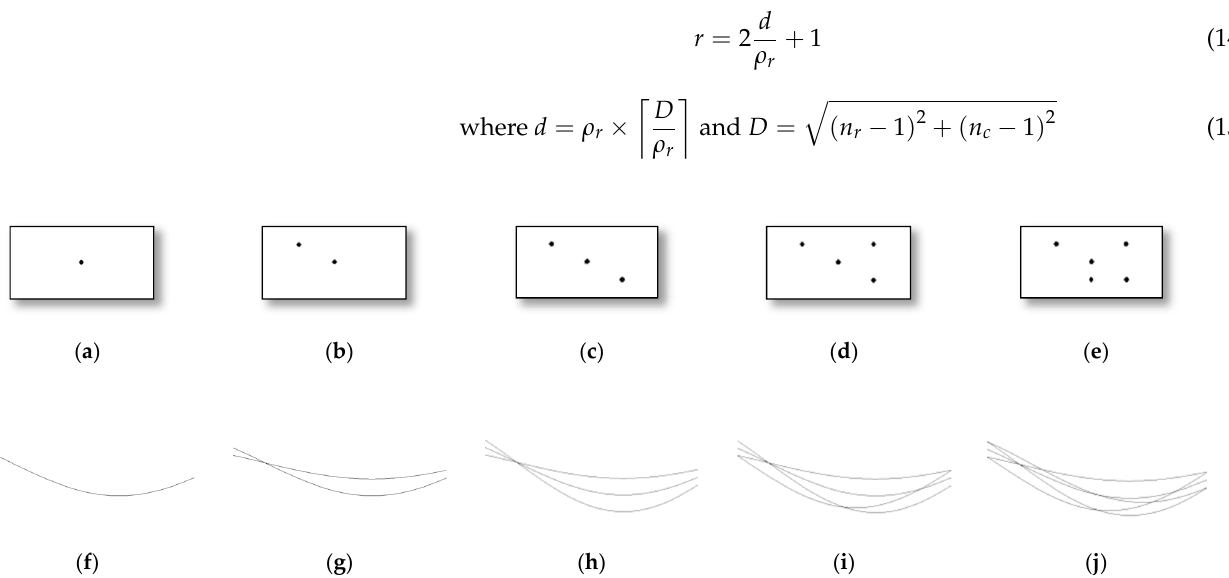
Figure 7. Pictorial representation of points in image space and Hough space. ( a – e ) show images containing 1–5 number of points respectively and ( f – j ) show corresponding lines in the Hough space.